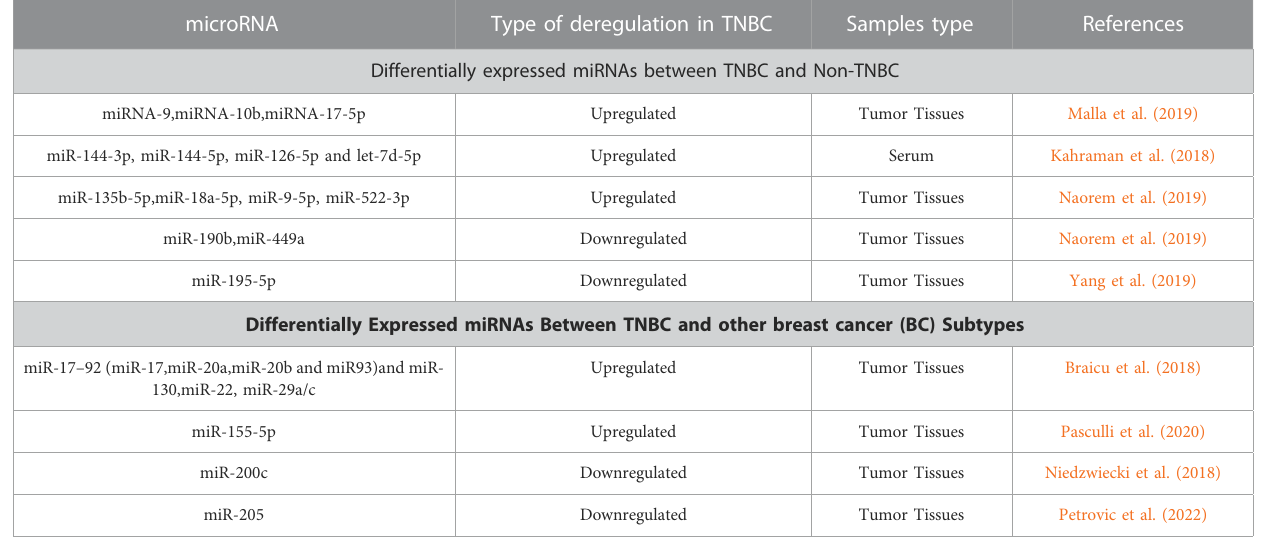
TABLE 1 Diagnosis related MicroRNAs.